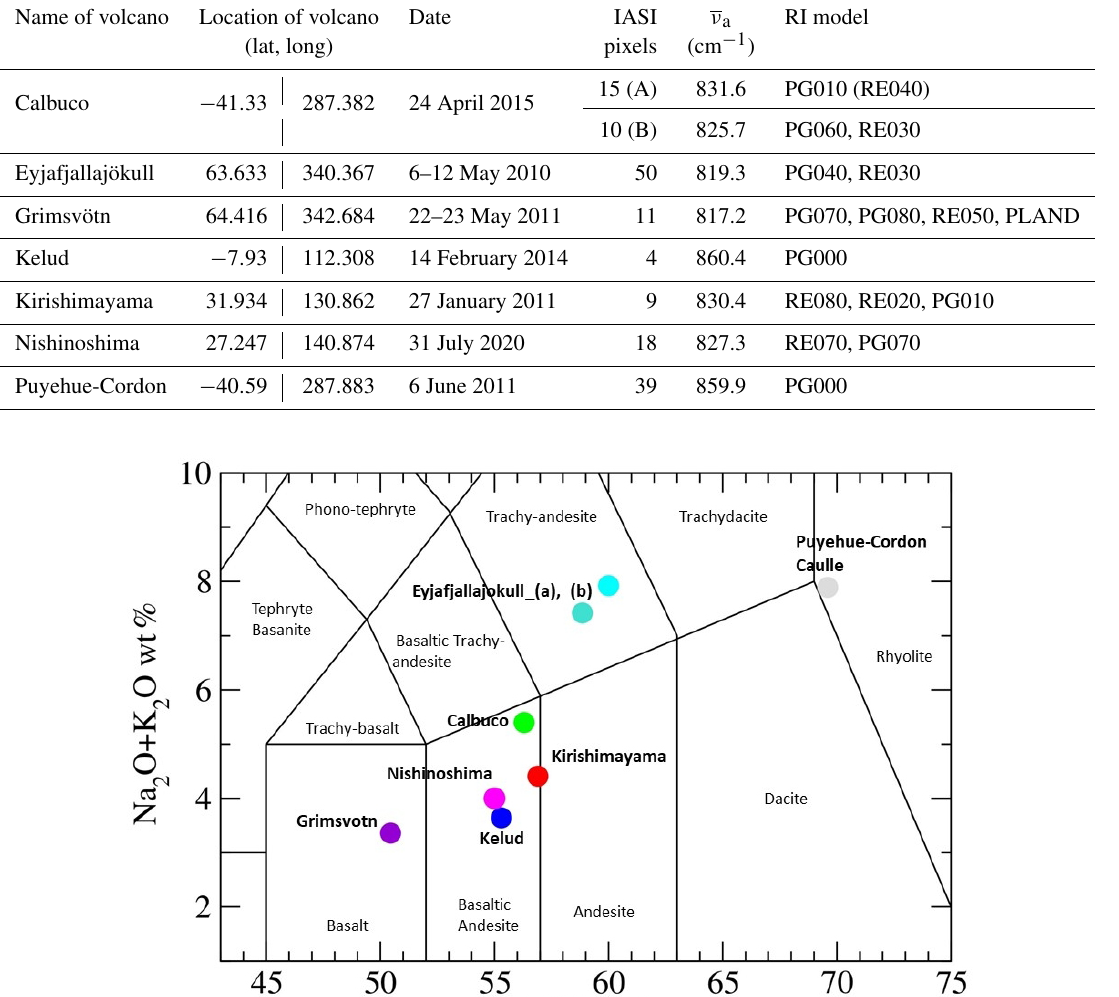
Table 2. Volcanic eruption events used for BTS analysis of IASI measurements and examples of the RI models. The RI models were selected through a comparison between measured and simulated BTS for IASI pixels on dates listed in the column “date”. Plural RI models in the column “RI model” indicate that the results of BTS fitting were almost the same. The average wavenumber ν a is that at which the measured brightness temperature is maximized in the range of 750cm − 1 ≤ ν ≤ 900cm − 1 . For the Calbuco eruptions, RI models for different ash plume locations, Calbuco_A and Calbuco_B, are listed separately.